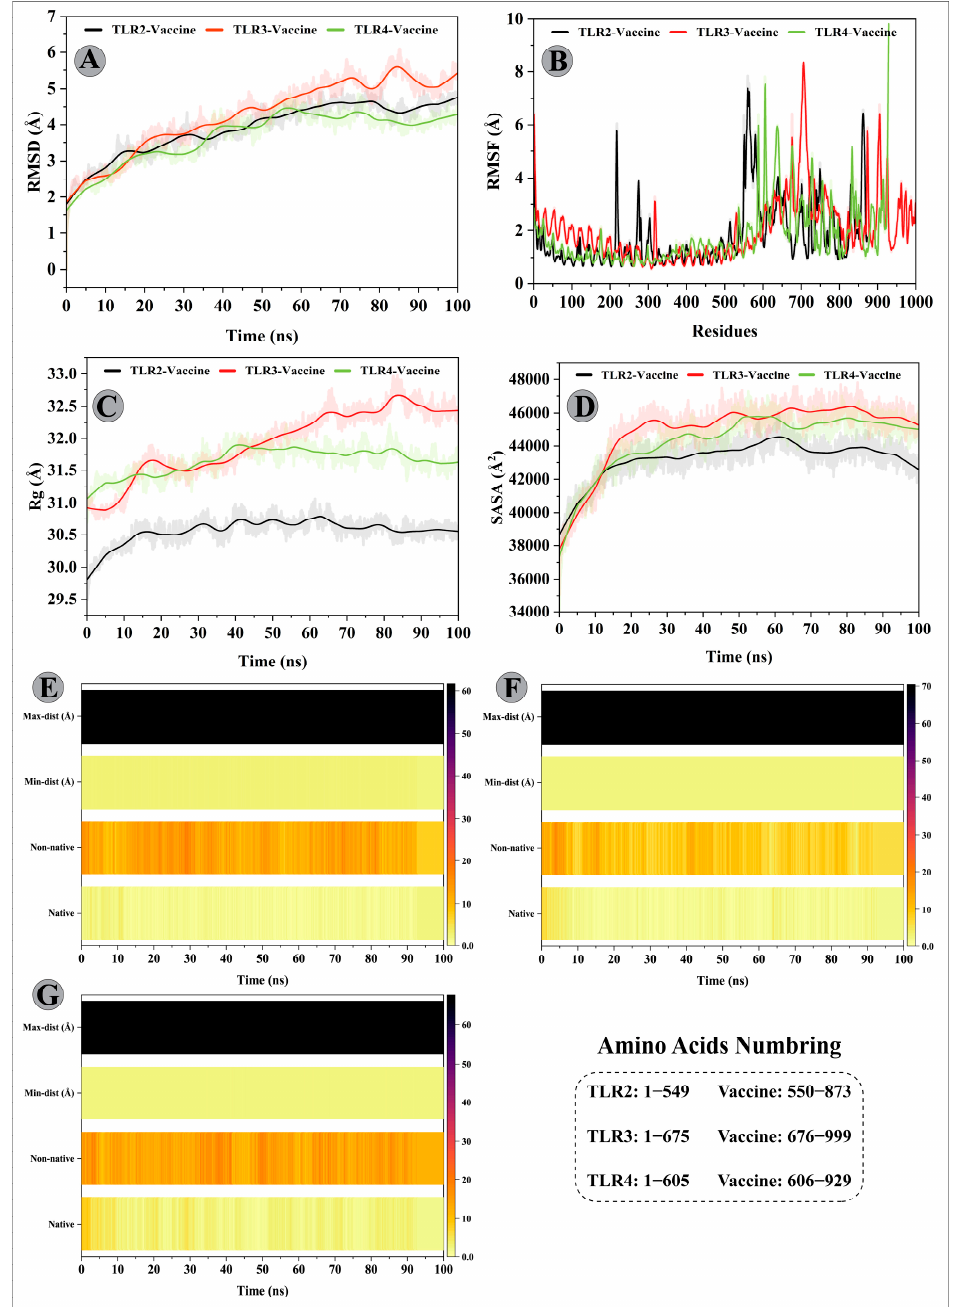
Figure 6. Molecular dynamics simulations analysis of the designed vaccine construct (ligand) and immune receptor (TLR2/3/4) complexes. ( A ) Root Mean Square Deviation (RMSD) plots of ligand and receptor complexes show no substantial deviations from their reference starting position and establishment of a stable complex. ( B ) Root Mean Square Fluctuation (RMSF) plots of ligand and receptor complexes demonstrating the flexibility of amino acid side chains. ( C ) The structural compactness of ligand–receptor complexes estimated over 100 ns simulation time is represented by the Radius of Gyration (Rg) plots. ( D ) Changes in the protein surface area accessible to the solvent over 100 ns simulation time represented by Solvent Accessible Surface Area (SASA) plots of ligand–receptor complexes. Native and non-native contacts between ( E ) Chimeric vaccine construct–TLR2 complex, ( F ) Chimeric vaccine construct–TLR3 complex, and ( G ) Chimeric vaccine construct–TLR4 complex estimated over the 100 ns simulation